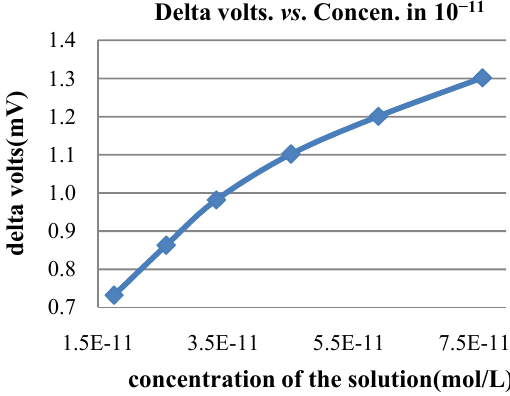
Figure 9. The relationship of the concentrations of the fluorescein solution samples and the voltage differences in 10 × 10 − 11 scale.